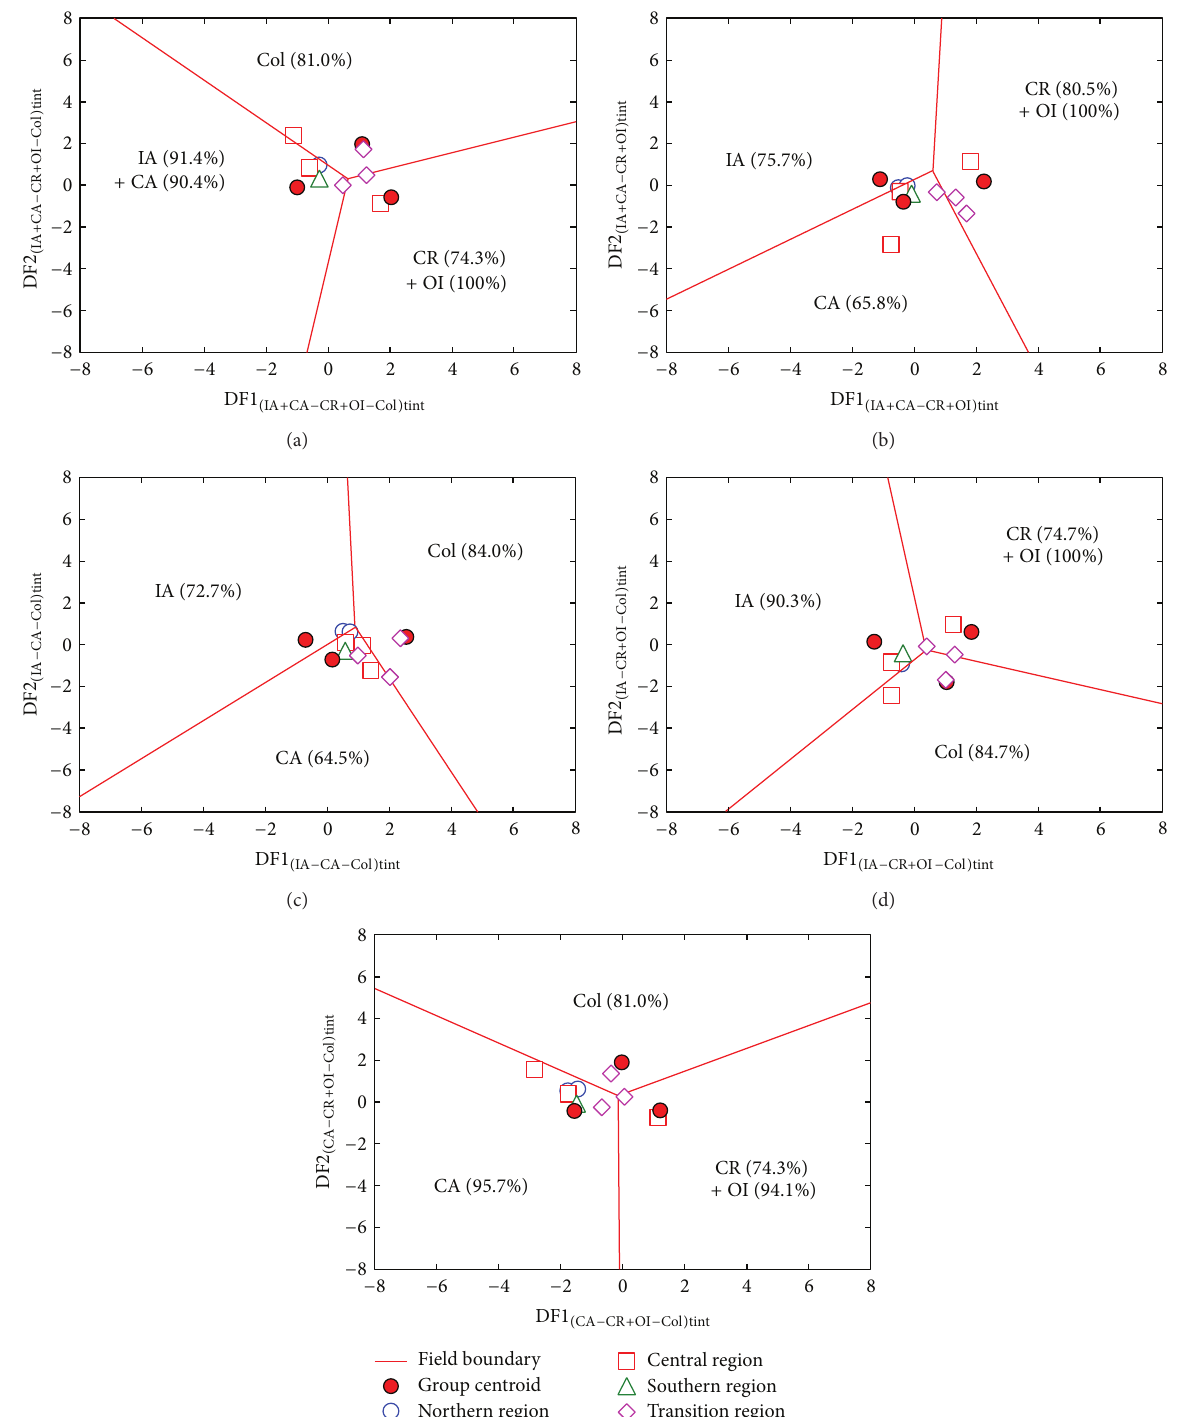
Figure 5: Discriminant-function multidimensional diagrams based on ln-transformed ratios of immobile trace elements for tectonic discrimination of intermediate Sierra de las Cruces magmas. The symbols are explained as inset in (a); more details are in Figure 3. The subscript “tint” in axis names refers to trace (t) element ratios for intermediate (int)